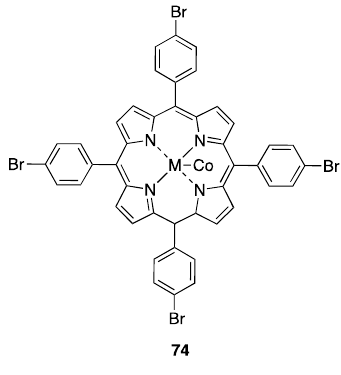
Figure 5. CoTBrCCl ( 74 )